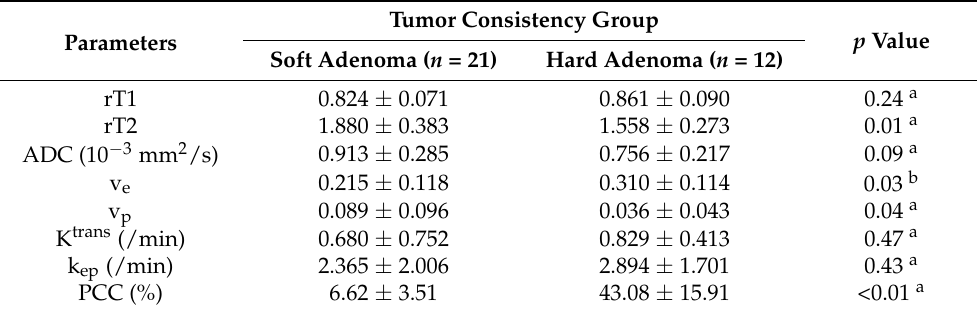
Table 7. MRI parameters and histologic percentage of collagen content of soft and hard nonfunction- ing adenomas. Tumor Consistency Group Parameters Soft Adenoma ( n =